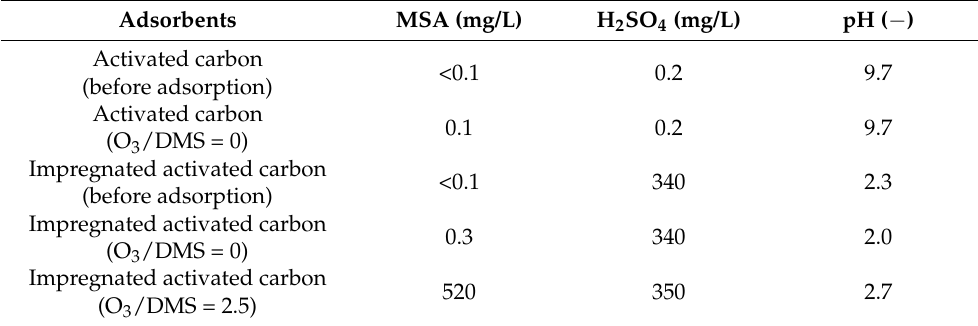
Table 5. MSA concentration and pH of ion exchanged water with